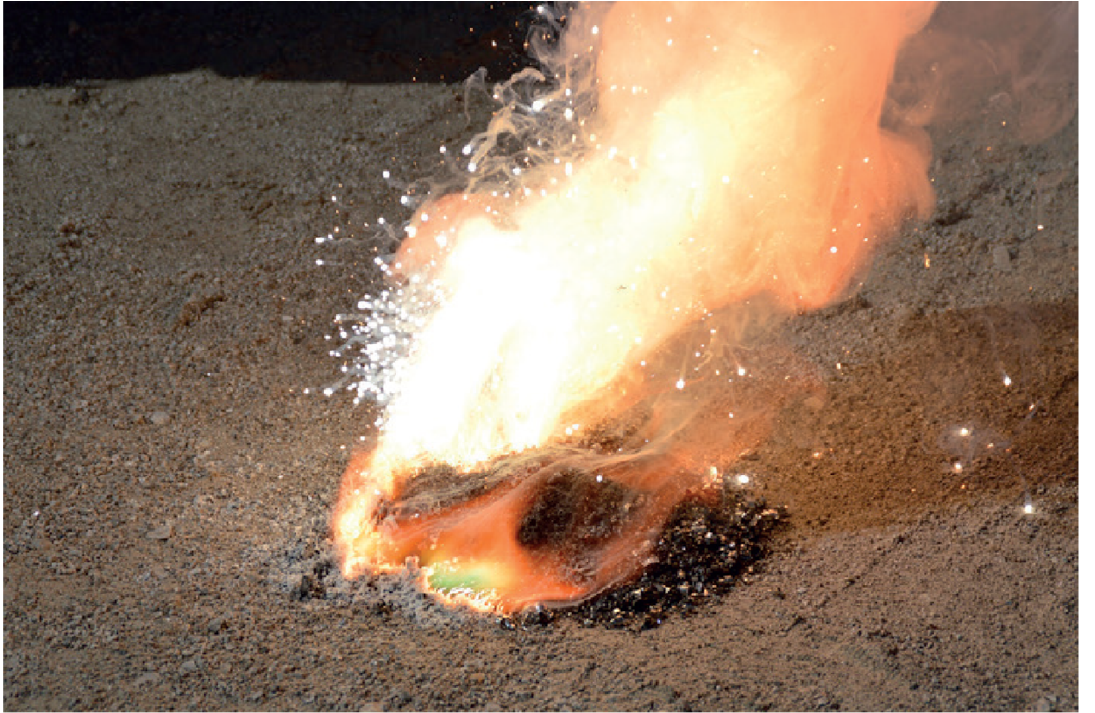
Figure 6. A pile of burning Mg (here 5 kg) covered by cellulose flakes. As soon as the crust is damaged (see in the left part of the picture, conducted here with a spade), the flames reemerge. Cooling of the intact charred cellulose cover is needed to bring the controlled fire to a stop.